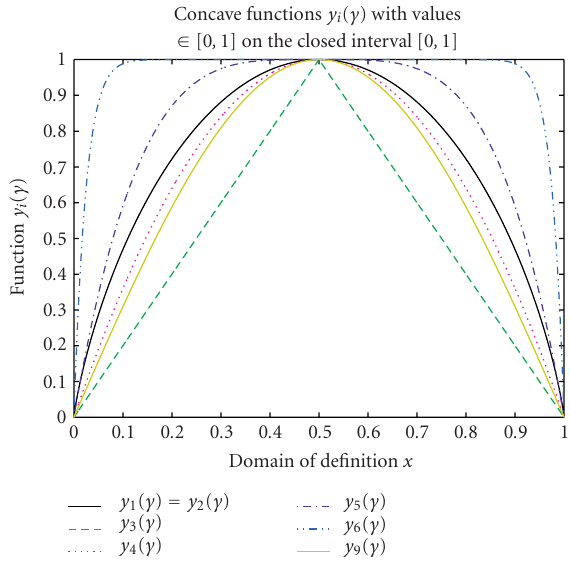
Figure 4.13. Comparison of the normalised concave entropy-like mixing functions y 1 , ... , y 6 and y 9 on the simplex S 1 , that is, the closed interval [0,1]. The tent function y 3 is an a ffi ne function, since it is concave and convex